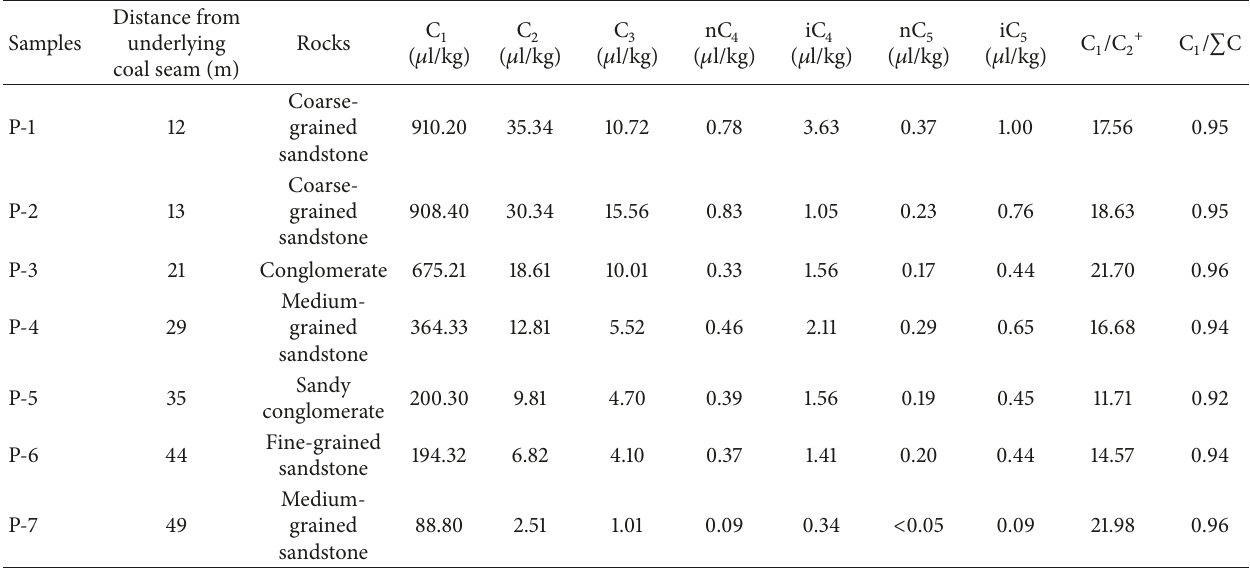
Table 3: Gas hydrocarbon composition in host rocks within the Mengqiguer uranium deposit. Distance from Samples underlying coal seam